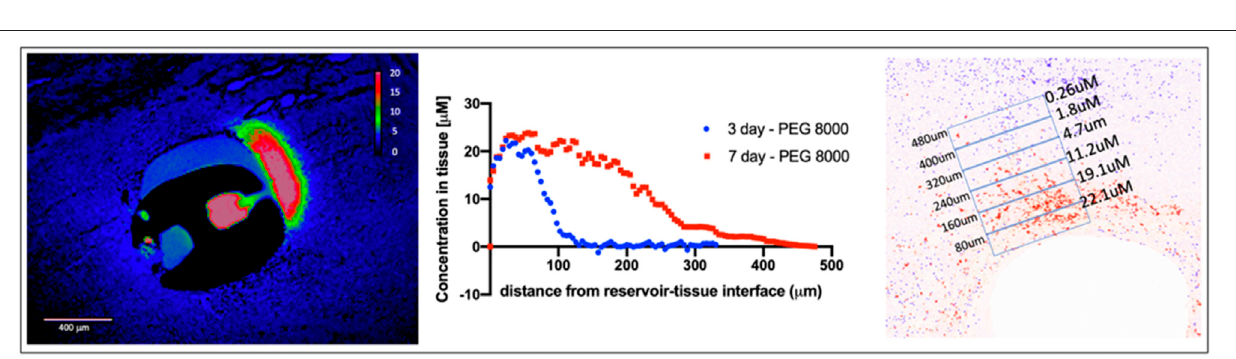
FIGURE2| Precisemeasurementofdrugconcentrationinthemurinebrain.(Left)Local drugreleaseofMK2206fromIMDreservoirintothalamus,measuredat t= 7d.(Middle)DrugconcentrationshownasafunctionofdistancealongthegradientromcenterofIMDreservoir.(Right)Distanceandconcentrationdependentdrugeffect to obtain intra-brain